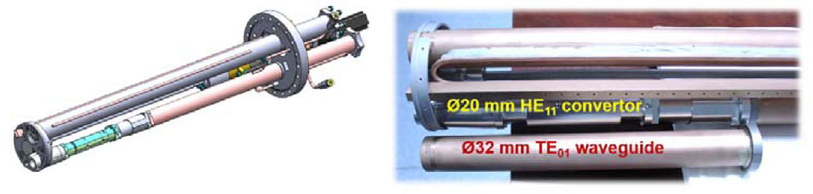
FIG. 16. Compact mode convertor from TE 01 to HE 11 .